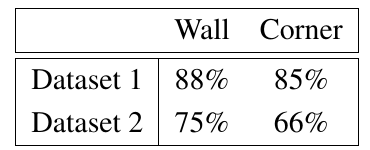
Classification results obtained using amplitude-based algorithm (true positive rates). Distances are lower than 1.5 m.